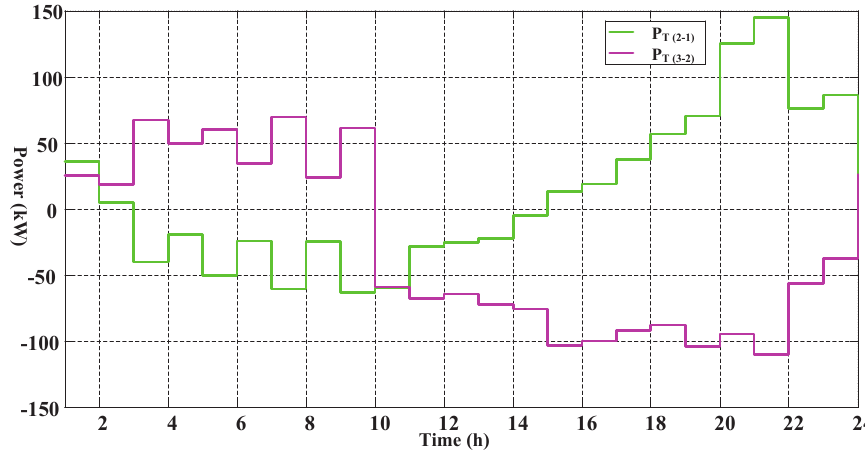
Figure 7. Exchanging power on DC-links.